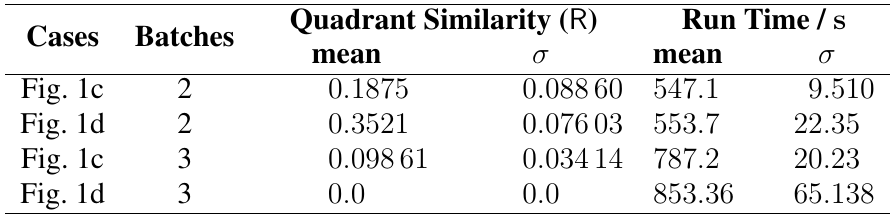
Table 1: Simulation quantum annealing data (mean of 30 runs), values to 4